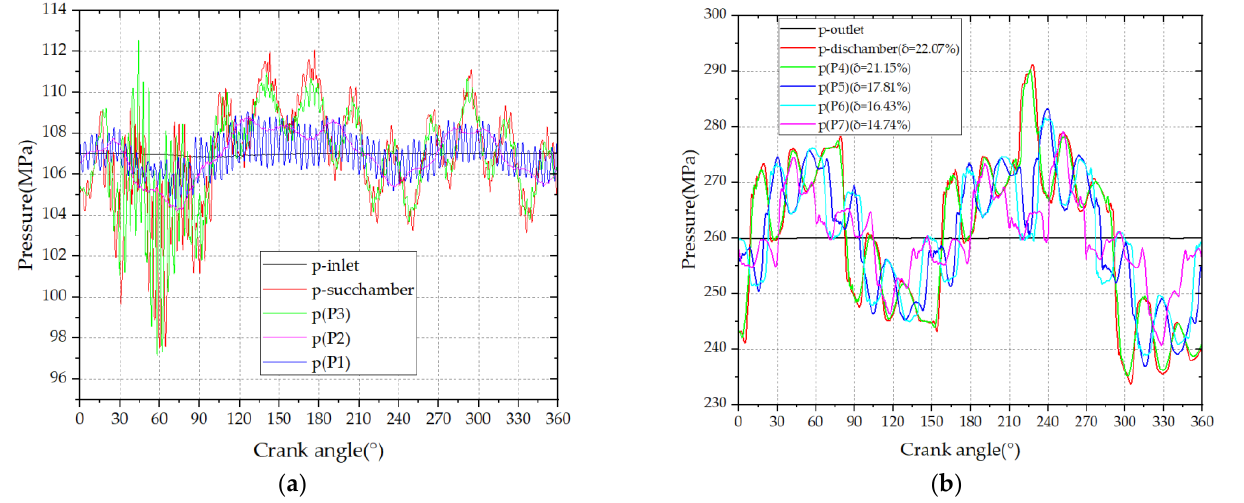
Figure 10. Pressure pulsation in the pipelines. ( a ) Pressure pulsation in the inlet pipeline; ( b ) pres- sure pulsation in the inlet pipeline.